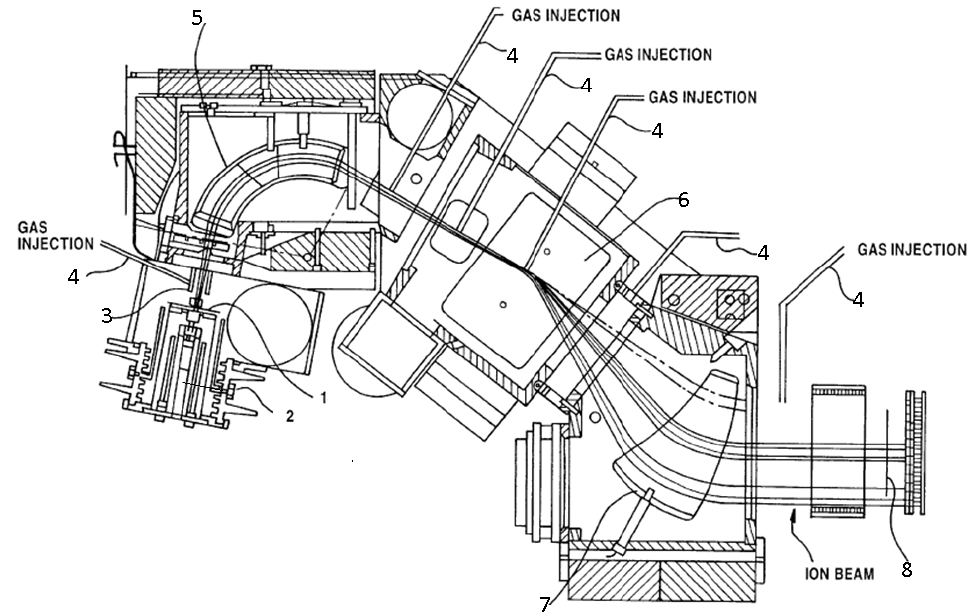
Figure 3. Schematic of experimental implanter for testing the small anode ion source. 1—extractor, 2—ion source, 3—tunnel, 4—gas injection, 5—analyzer magnet, 6—scanning magnet, 7—collimator magnet, 8—wafer holder.